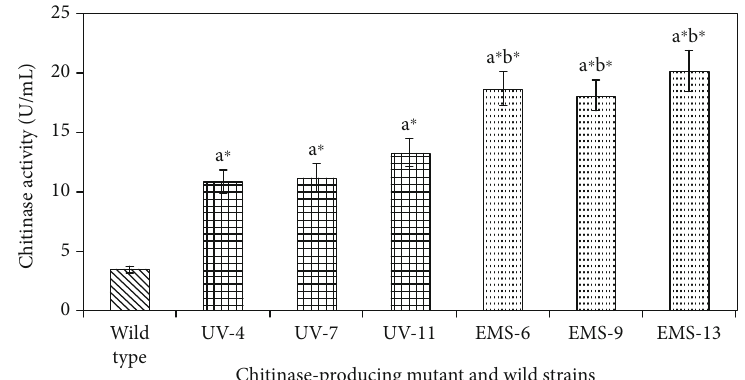
Figure 1: Speci fi c chitinolytic activity of Bacillus licheniformis SSCL-10 wild type along with maximum chitinolytic activity of three mutants of UV and EMS strains. Values with a ∗ b ∗ are signi fi cantly ( p < 0 : 05 ) higher activity. a ∗ : wild type compared with UV and EMS mutant. b 6 : UV compared with EMS mutant.